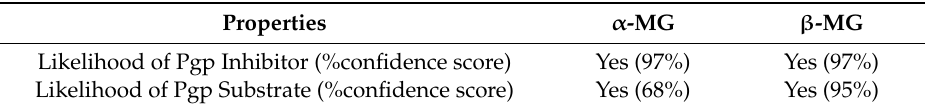
Table 1. The predictive likelihood of α-mangostin (α-MG) and β-mangostin (β-MG) to interact with Pgp via the ADMET Predictor™ program.